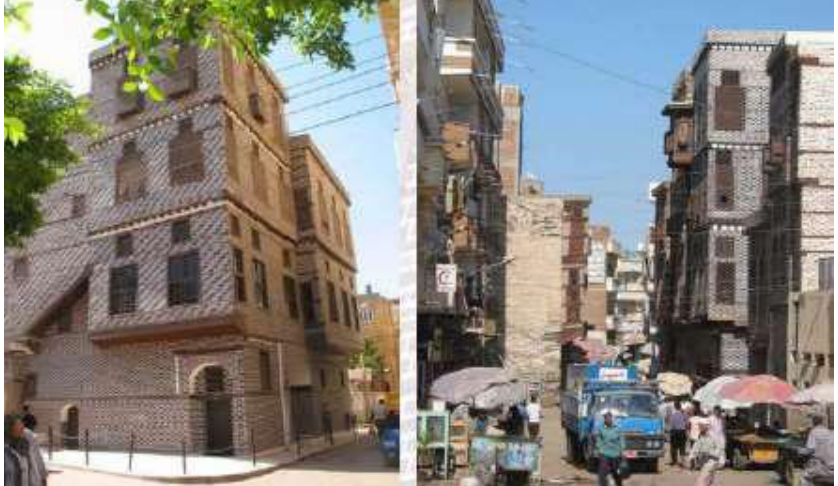
Figure 13. Current sutiation of the historical residential building in